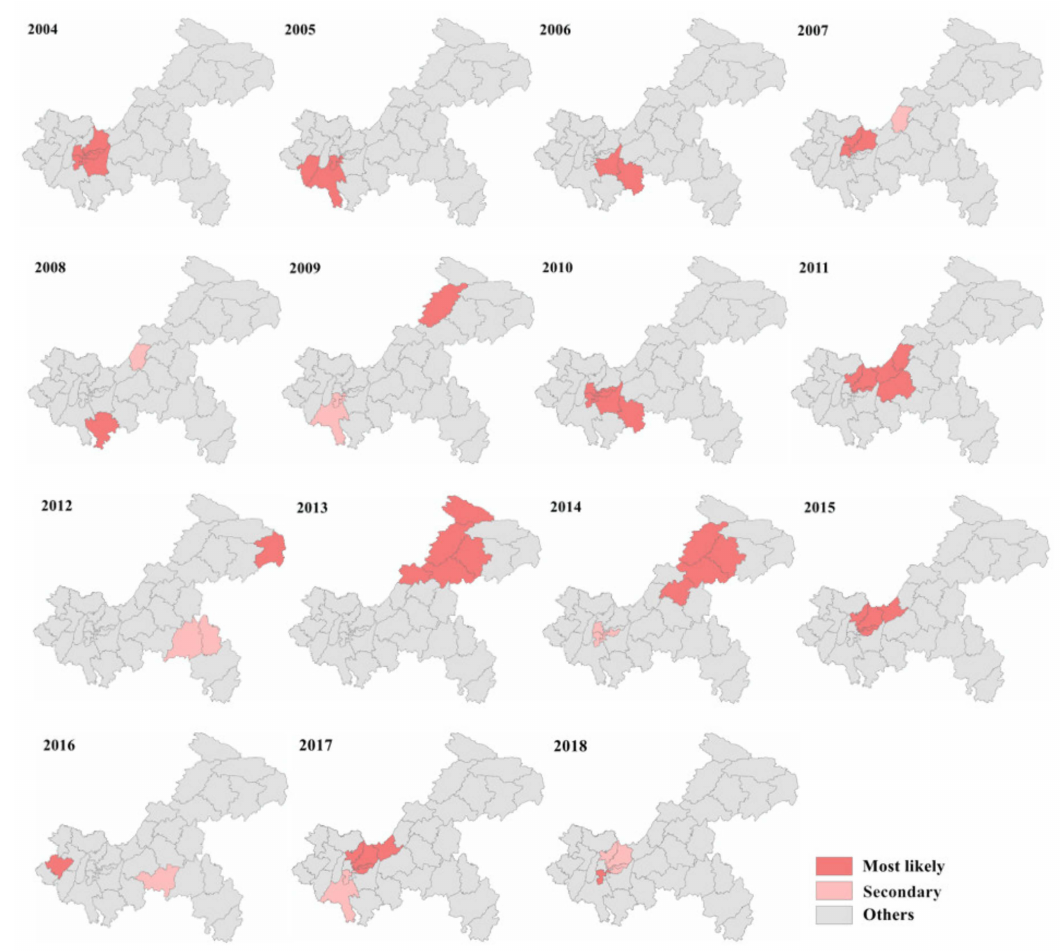
Figure 5. Yearly spatial clusters of mumps in Chongqing from 2004 to 2018.